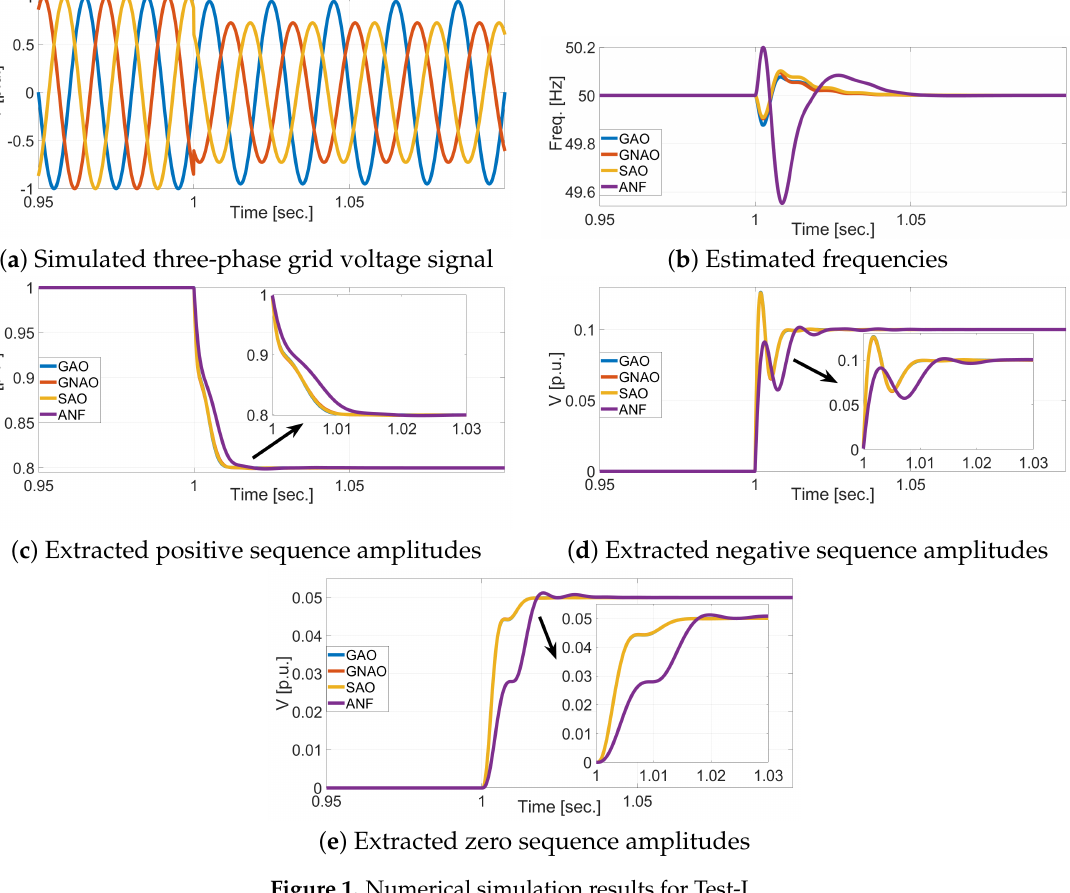
Figure 1. Numerical simulation results for